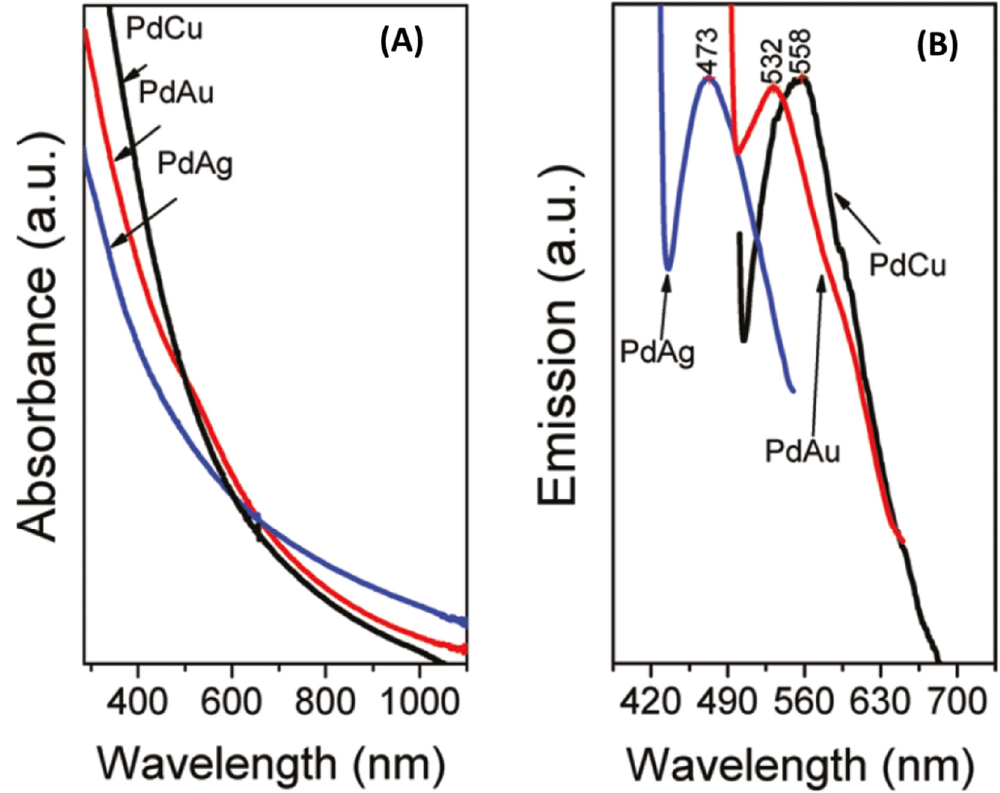
Figure 7. ( A ) UV-vis and ( B ) photoemission spectra of PdCu, PdAu, and PdAg nanocrystals in toluene solution. Adapted with permission from the American Chemical Society. Copyright 2009 American Chemical Society.